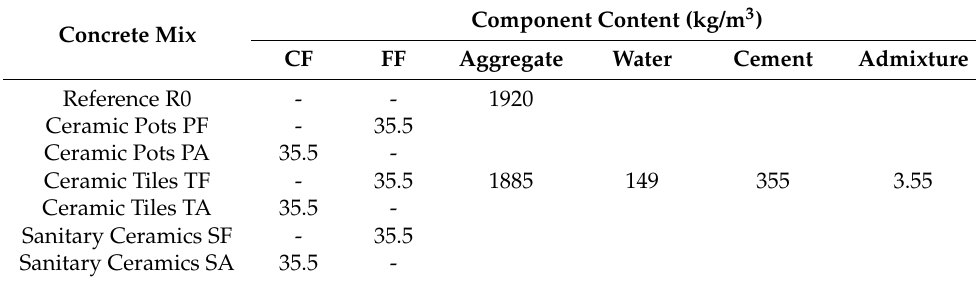
Table 3. The compositions of the tested concrete